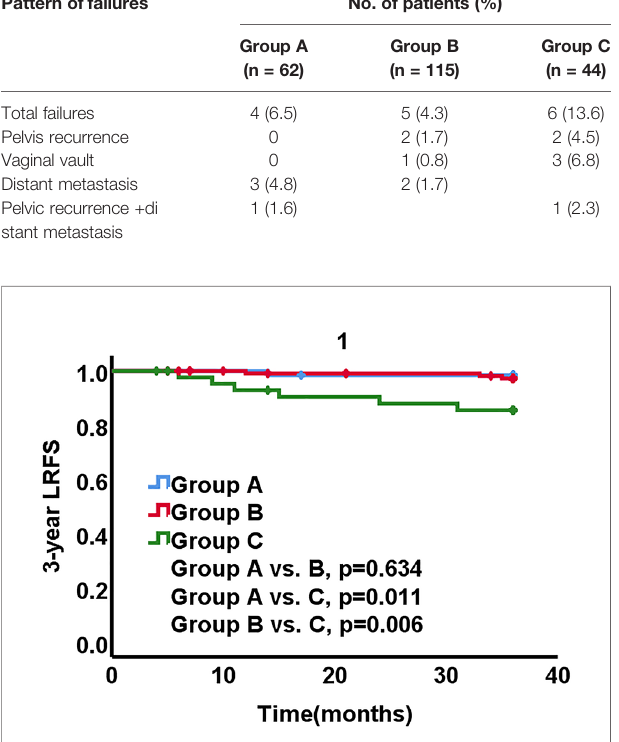
FIGURE 1 | Local recurrence-free survival (LRFS) strati fi ed by three groups. Group A, laparoscopic hysterectomy and adjuvant radiotherapy; Group B, open surgery; Group C, laparoscopic hysterectomy